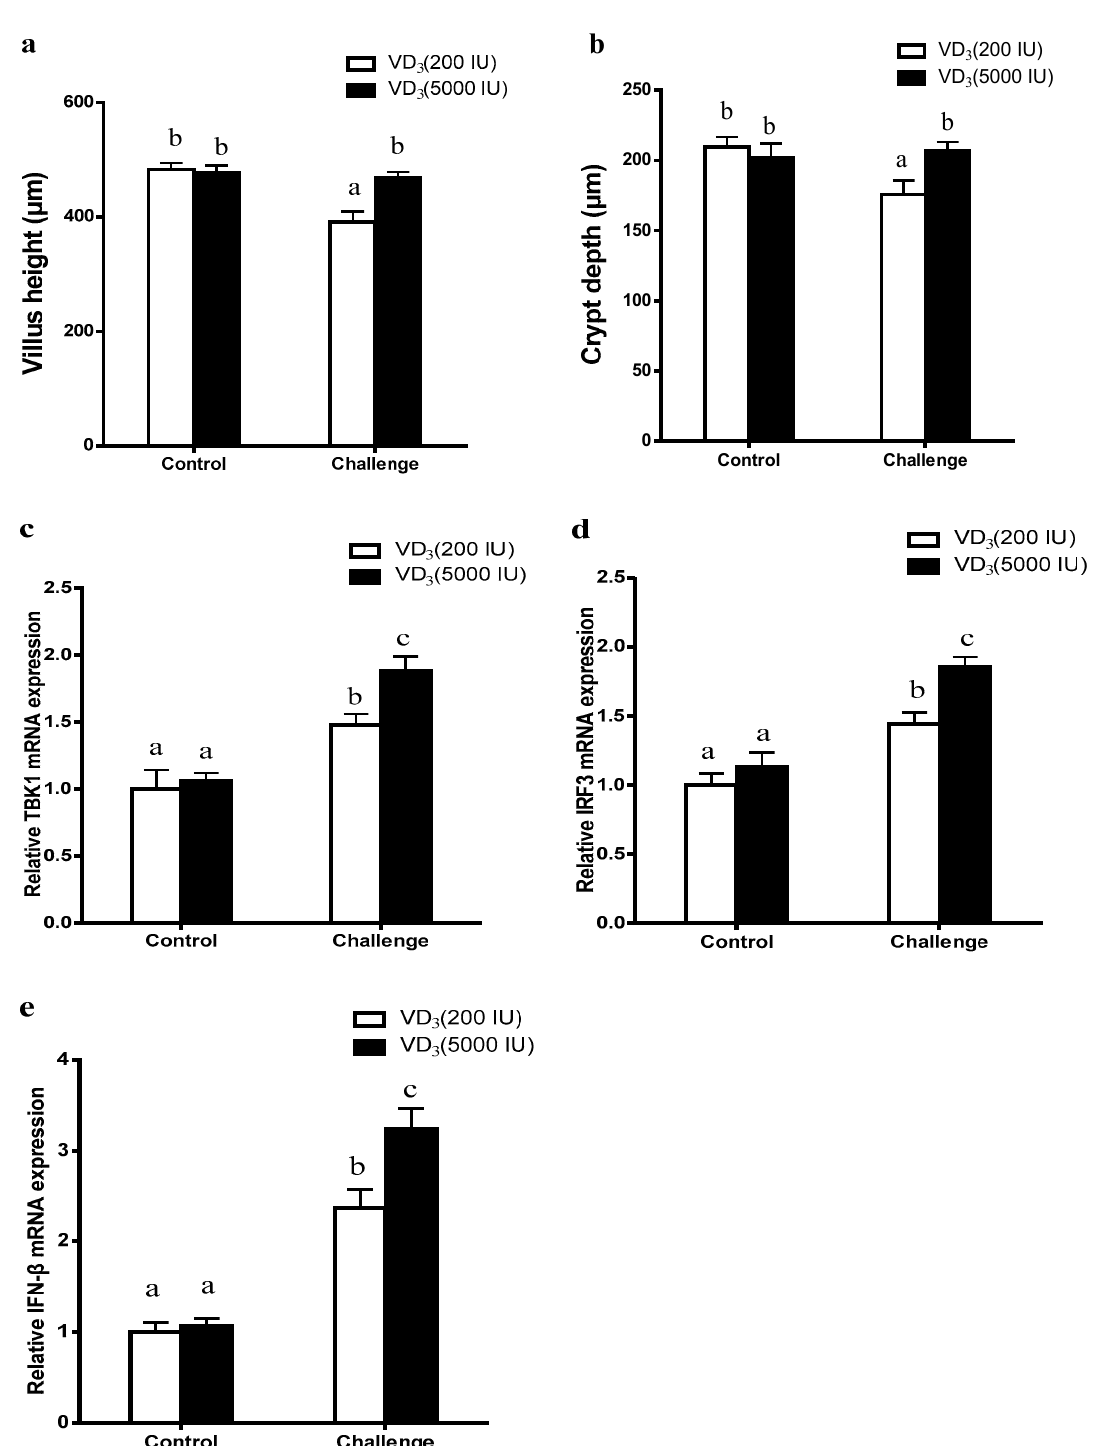
Figure 1. E ff ect of rotavirus (RV) challenge and vitamin D 3 (VD 3 ) supplement on the villus height ( a ), crypt depth ( b ), and TBK1 ( c ), IRF3 ( d ), and IFN- β ( e ) mRNA expressions in the porcine jejunum. Data are present as the mean ± SD, n = 6 / group. a,b,c : Means with di ff erent letters on vertical bars indicate significant di ff erences ( p < 0.05).